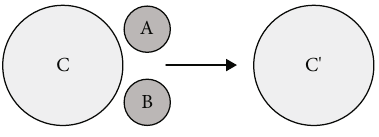
Figure 5: No containment relationship.